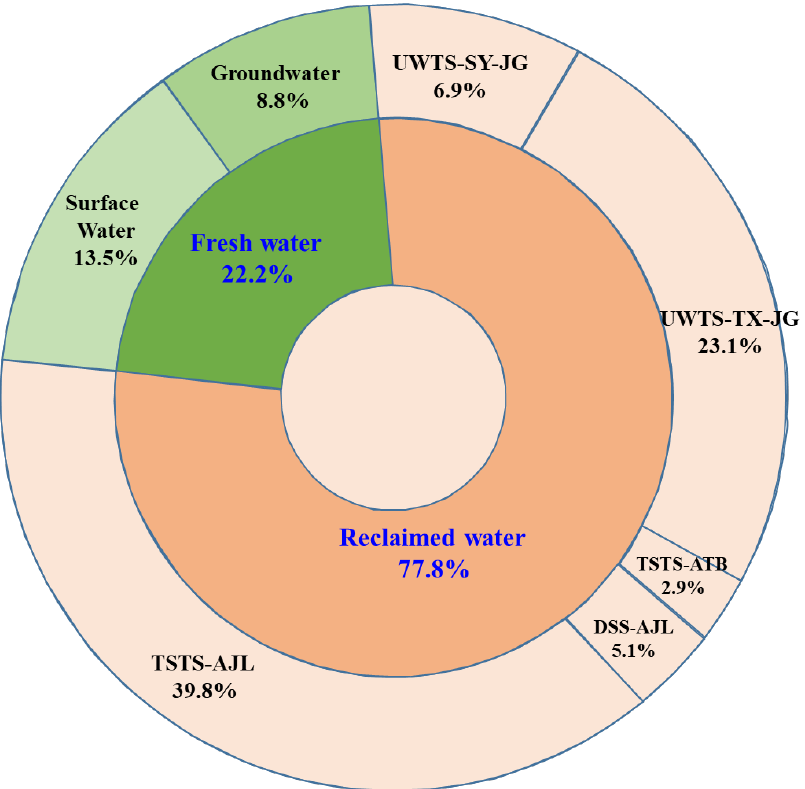
Figure 3. Water source structure after optimal allocation of water resources in the study area.